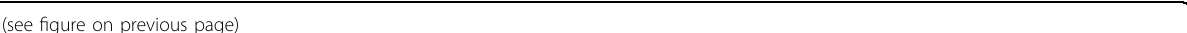
table: prediction of STAT3-binding sites within TINCR promoter region, from JASPAR database. b Enrichment peak of STAT3 in the promoter of TINCR in ChIP-seq of HCC70 cells in ENCODE database. c TINCR expression is positively correlated with STAT3 mRNA expression in 1019 cancer cell lines